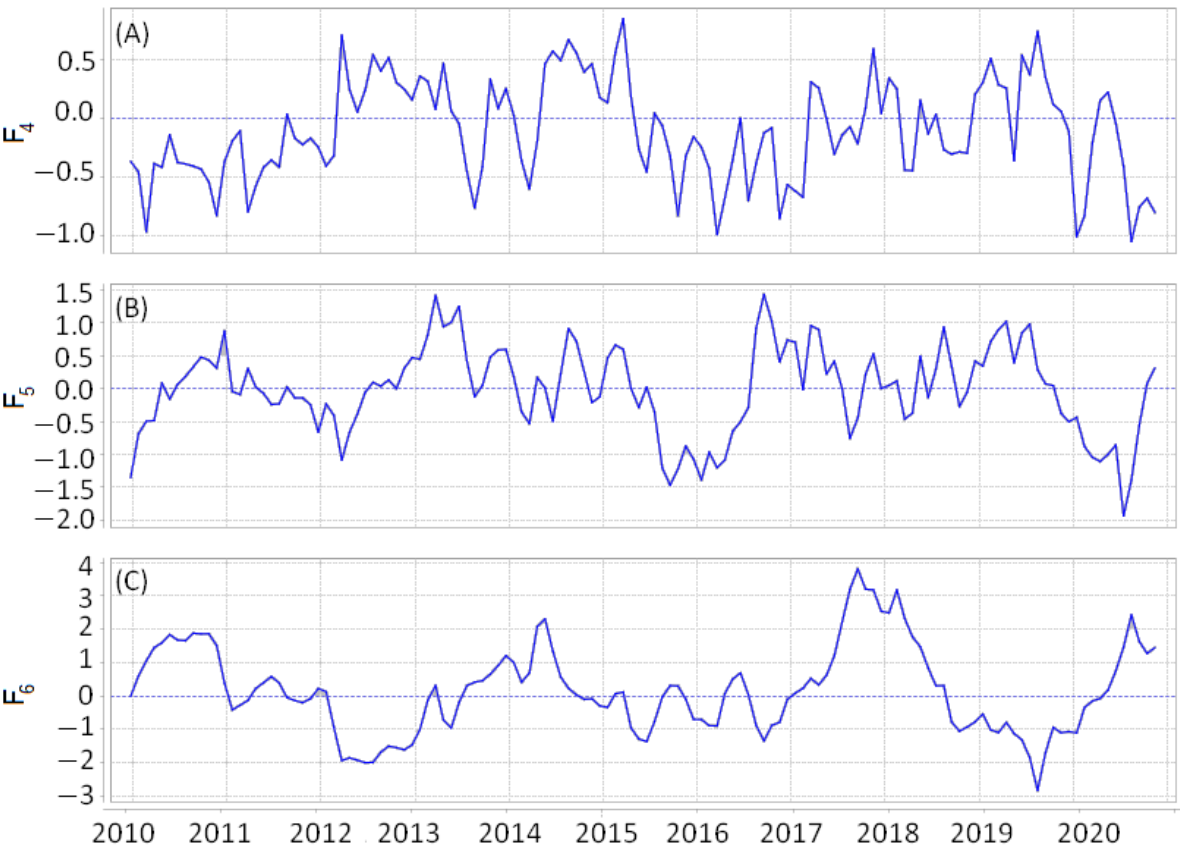
Figure 11. California. Time series at point 39.49 ◦ N and 123.2 ◦ W. ( A ) Field F 4 ; ( B ) field F 5 ; ( C ) field F 6